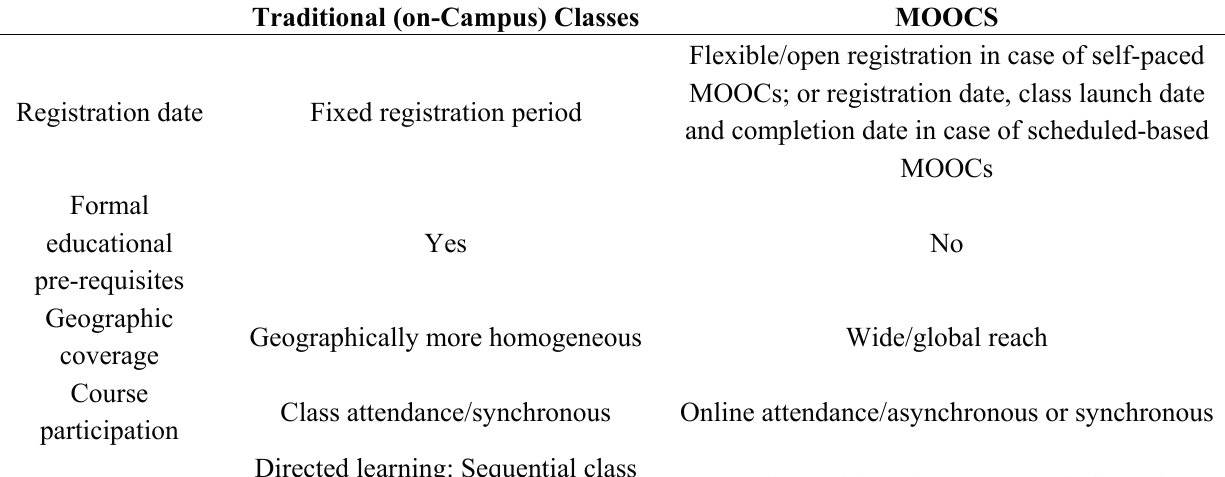
Table 1. Differences between traditional classes and